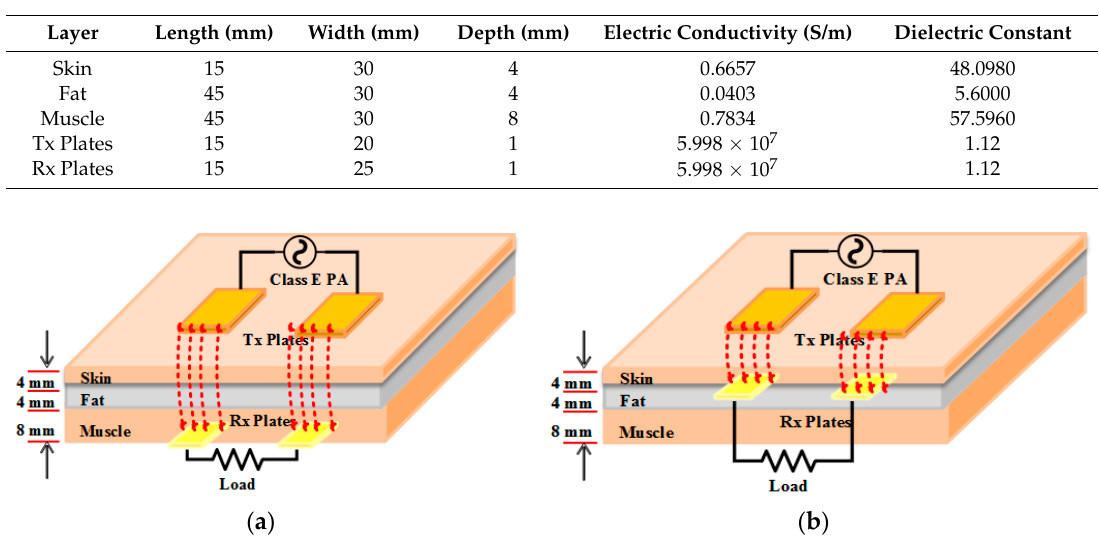
Figure 15. Schematic diagram of tissue with capacitive plates: ( a ) Rx plates under Muscle; and ( b ) Rx plates under skin.